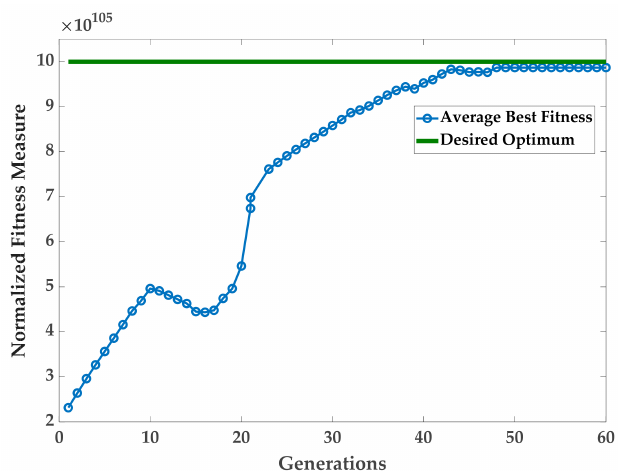
Figure 5. Convergence of the fitness measure with the